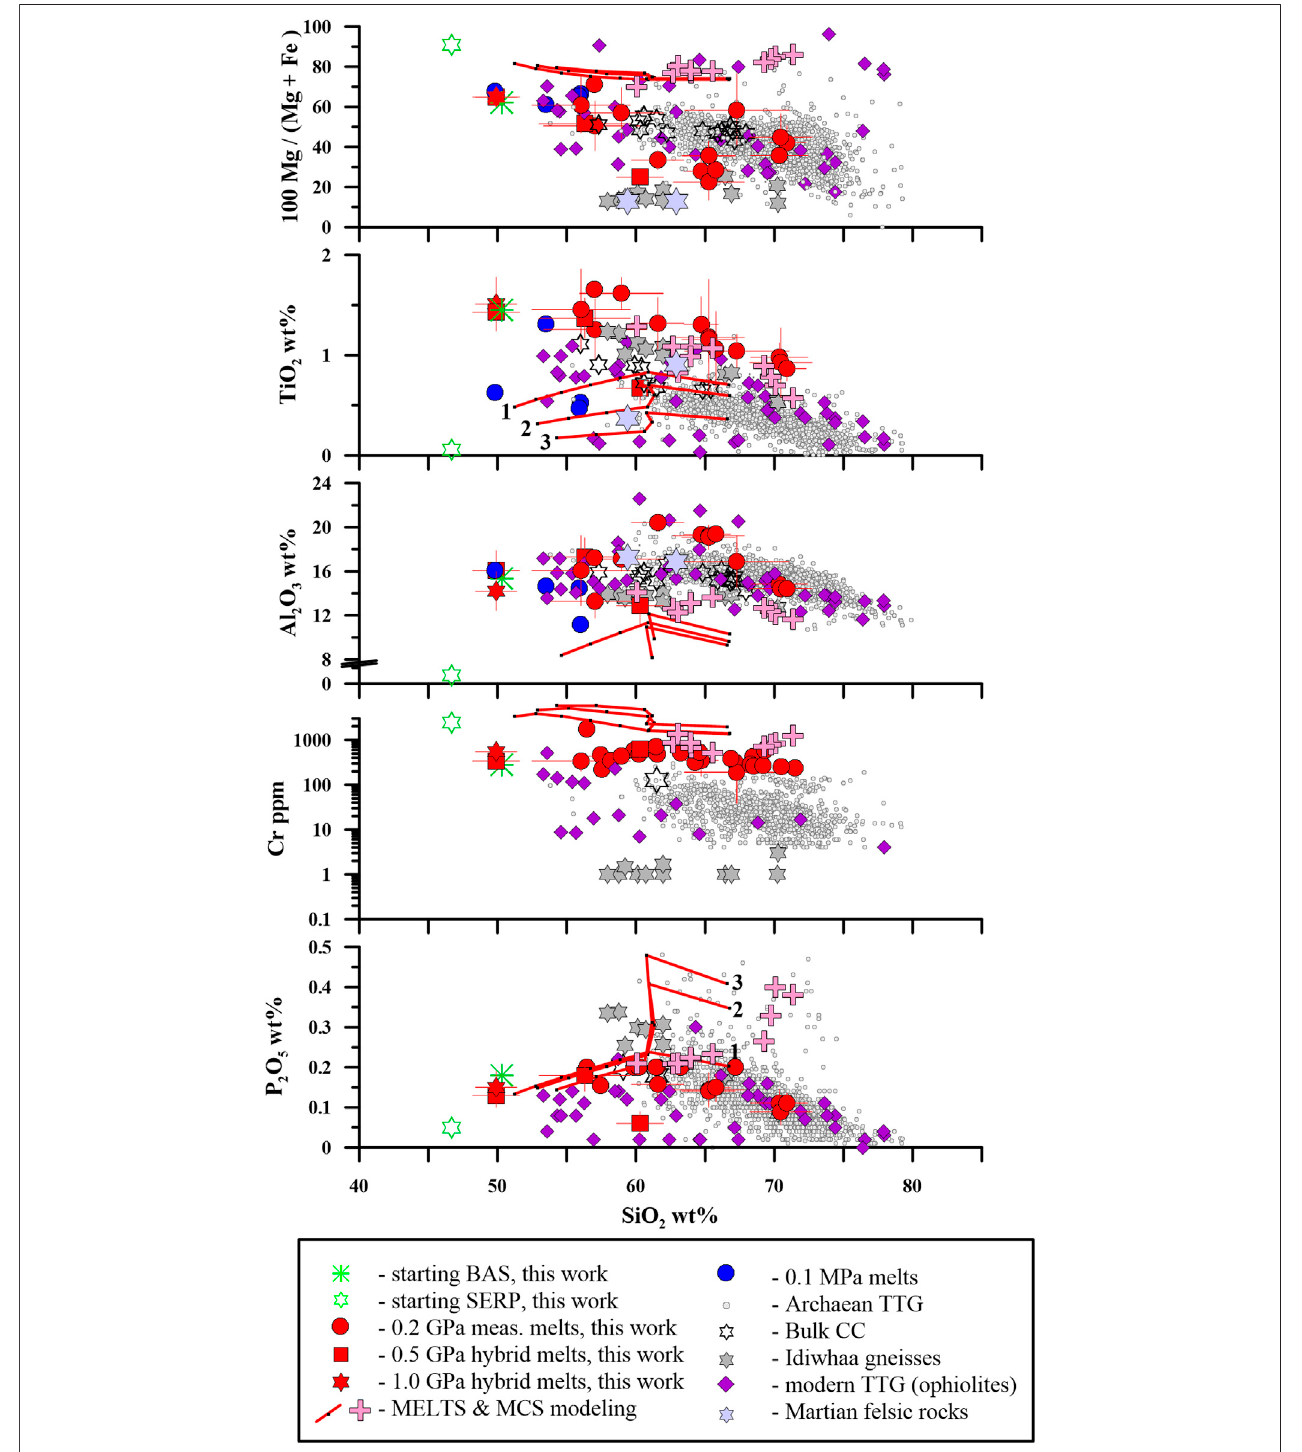
FIGURE 6 | Magnesium index (100 Mg/(Mg + Fe)), major and minor Ti, Al, P oxides (in wt%), and Cr (in ppm) vs. SiO 2 (in wt%) in interstitial glasses produced at 0.2 – 1.0 GPa during serpentinite-basalt interaction of hybrid and mixed runs. The major element compositions of the measured (meas.) melts are recalculated to 100% on a volatile-free basis. The error bars re fl ect the felsic glass inter-sample heterogeneity compared to the mean values ( Supplementary Tables S3, S4 ). The glass composition is compared to the starting basalt (BAS) and serpentinite (SERP), the anhydrous 0.1 MPa experimental glasses (Fisk, 1986), modern TTG (plagiogranites) in mantle sections of ophiolites (Amri et al., 1996, 2007; Shervais, 2008; Xu et al., 2017), the bulk Earth continental crust (Bulk CC) (Wedepohl, 1995;